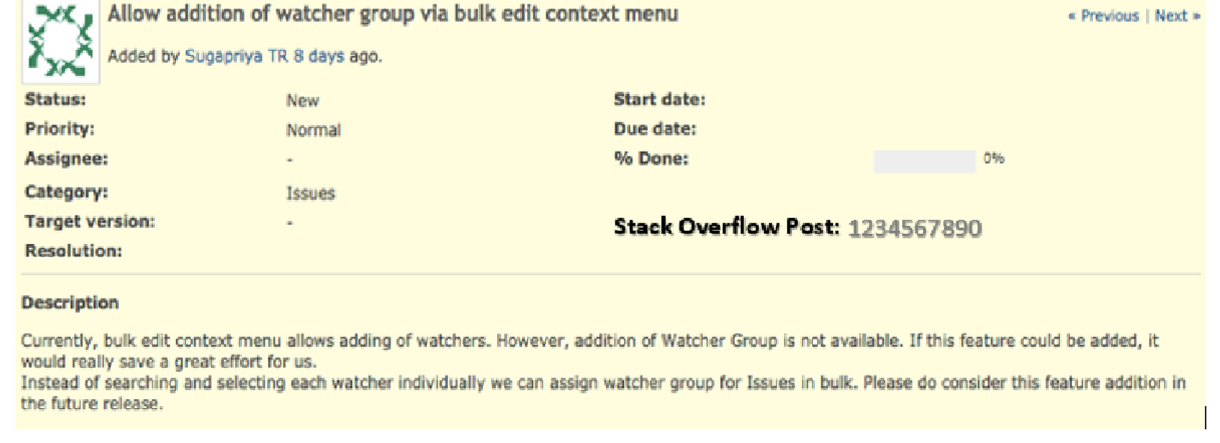
Fig 5. Redmine project task with SO customized